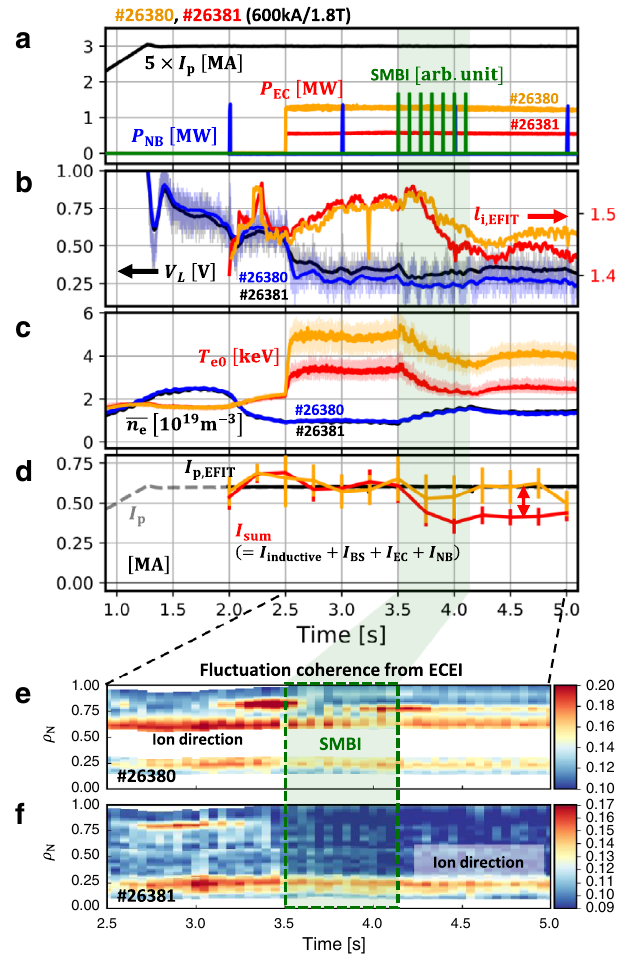
Fig. 6 | Comparison of main parameters between shot #26380 and #26381. a Plasma current ( I p ), neutral beam injection ( P NB ) and electron cyclotron ( P EC ) power, and supersonic molecular beam injection (SMBI). b Loop voltage ( V L ) and internal inductance ( l i ). c Central electron temperature ( T e0 ) and line-averaged density ( (cid:1) n e ). d Comparison of the total current obtained by interpretive simula- tions. Electron temperature fl uctuation coherence was measured by the electron cyclotron emission imaging (ECEI) system for #26380 ( e ) and #26381 ( f ). The ver- tical shade in light green represents the time period where SMBI is applied.